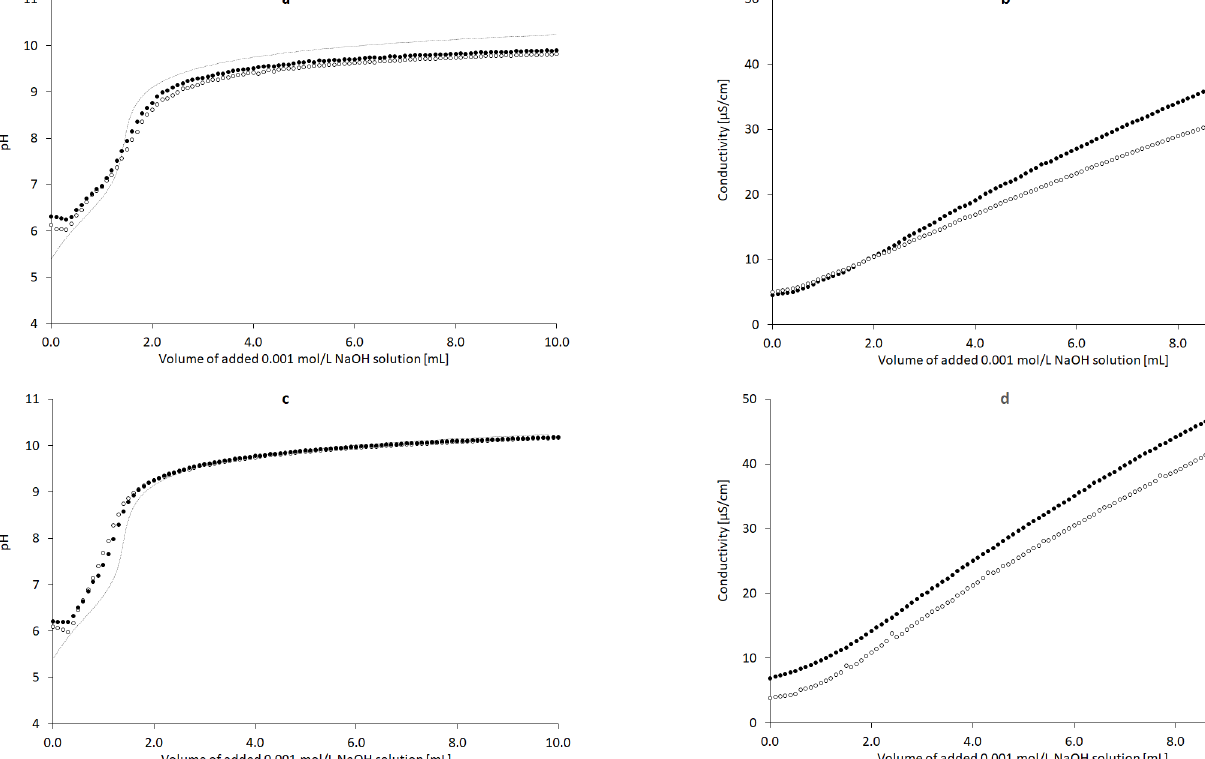
Figure 5. Influence of added volume of the 0.001 mol/L NaOH solution on the pH and conductivity of the dispersion of 5 mg of nondoped CT (( a , b ), n = 3) and CT doped with 3.3% ethanol w / w (( c , d ), n = 3); deionized water ( ◦ ), deionized water with CT ( • ), theoretical pH plot presenting the influence of ca. 0.004 mmol/L CO 2 from the atmosphere ( … ).